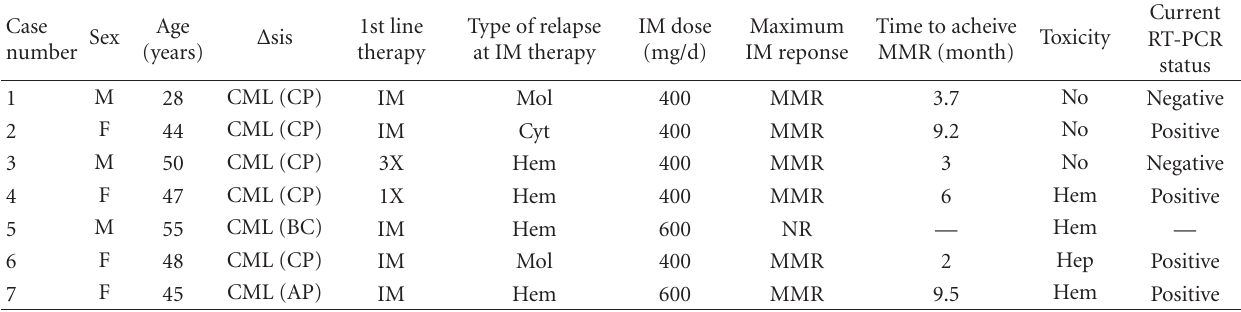
Table 1: Patients characteristics, CML stage and IM response. F: Female, M: Male, Δ sis: Diagnosis, CP: chronic phase, BC: blastic crisis, AP: accelerated phase, IM: imatinib, Mol: molecular, Hem: hematologic, Cyt: cytogenetic, Hep: hepatic, MMR: major molecular reponse, NR: no